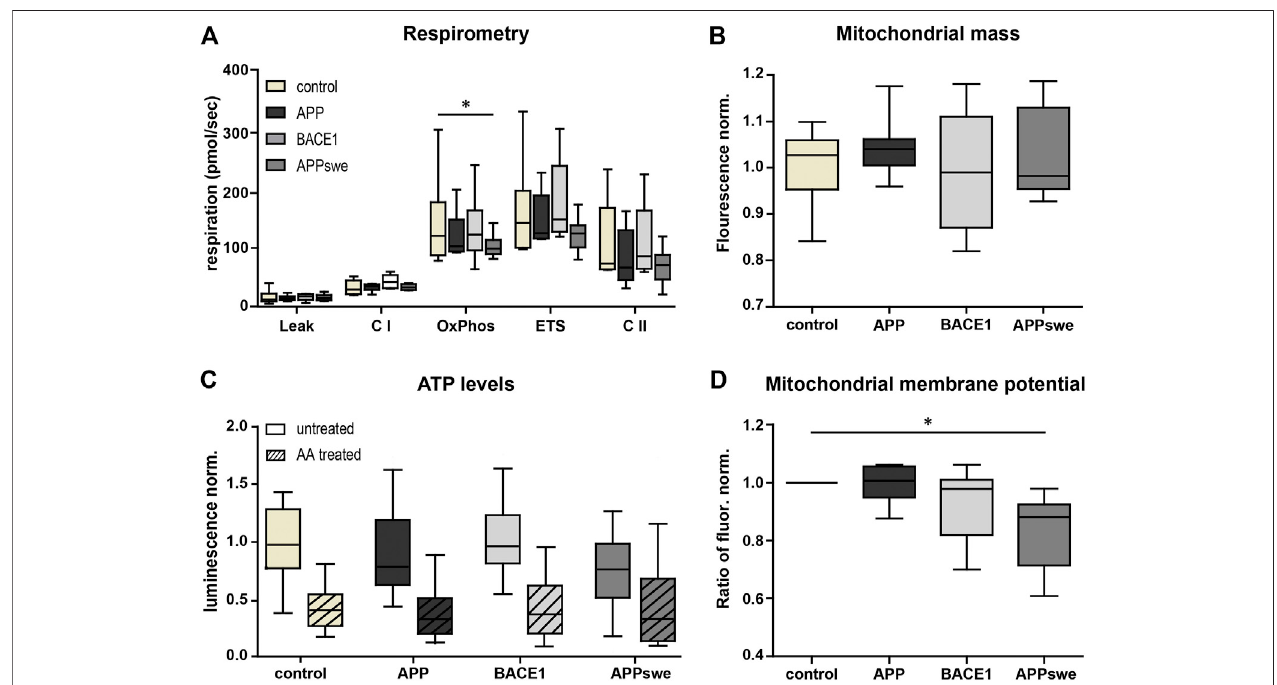
FIGURE 2 | Metabolic characterization shows decreased OxPhos capacity and mitochondrial membrane potential in APPswe-transduced primary hippocampal neurons. (A) High-resolution respirometry of permeabilized neurons was performed in an Oroboros Oxygraph-2k. All respiratory states were normalized to citrate synthaseactivity.Signi fi cancevs.controlwascalculatedusingtheFriedmantestandDunn ’ smultiplecomparisontest(n (cid:2) 6,eachinduplicates). (B) Mitochondrialmass measured as Mitotracker Green fl uorescence intensity normalized to control. Statistics were calculated using ANOVA with Bonferroni ’ s multiple comparison test (n (cid:2) 5, each in quintuplicates). (C) ATP levels were determined using luminescence assay kit ATPlight. AA (5 mM) was added acutely to distinguish ATP deriving from glycolysis and respiration. Fold change to pUltra-hot control was calculated. Signi fi cance vs. control was calculated using the Kruskal – Wallis test with Dunn ’ s